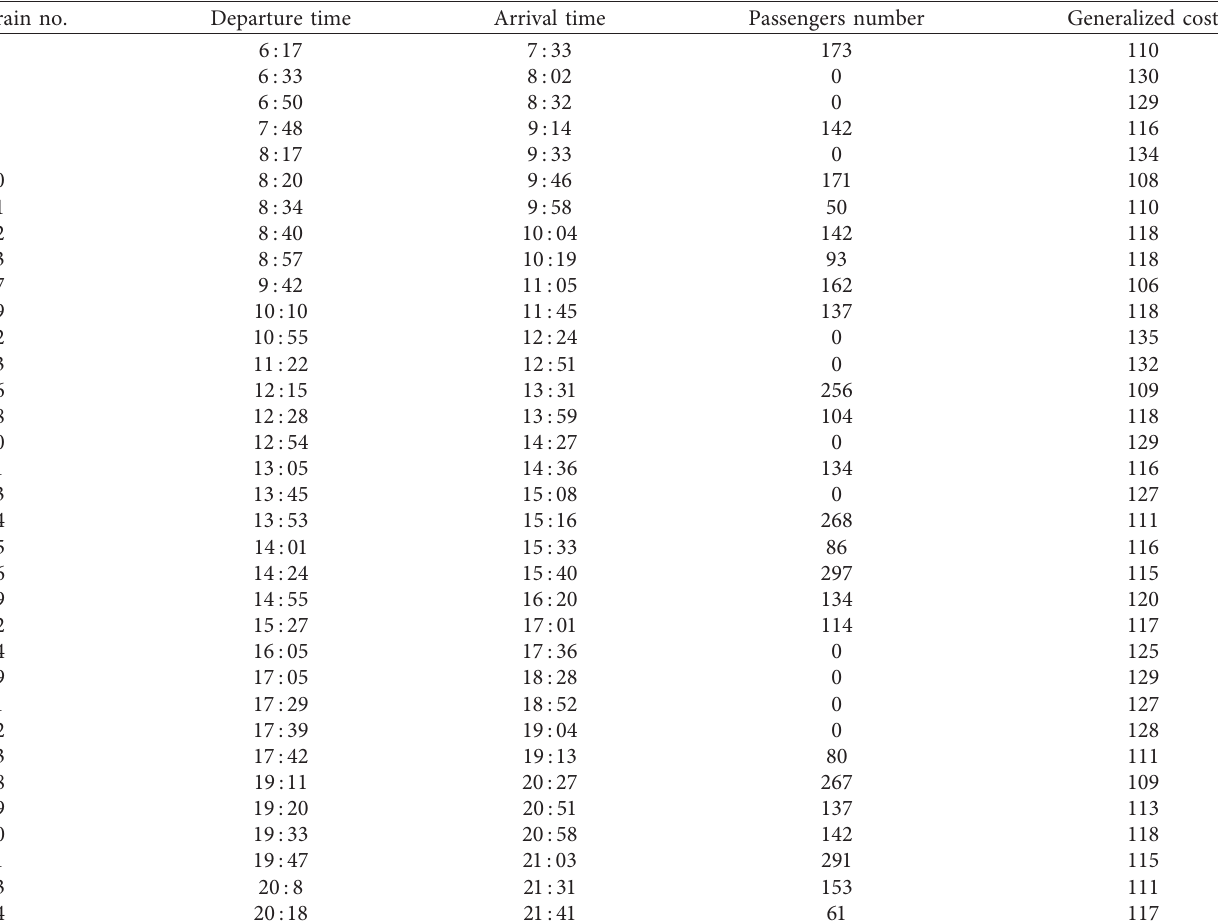
Table 9: Departure/arrival time and travel generalized cost for OD pairs (1,5). Train